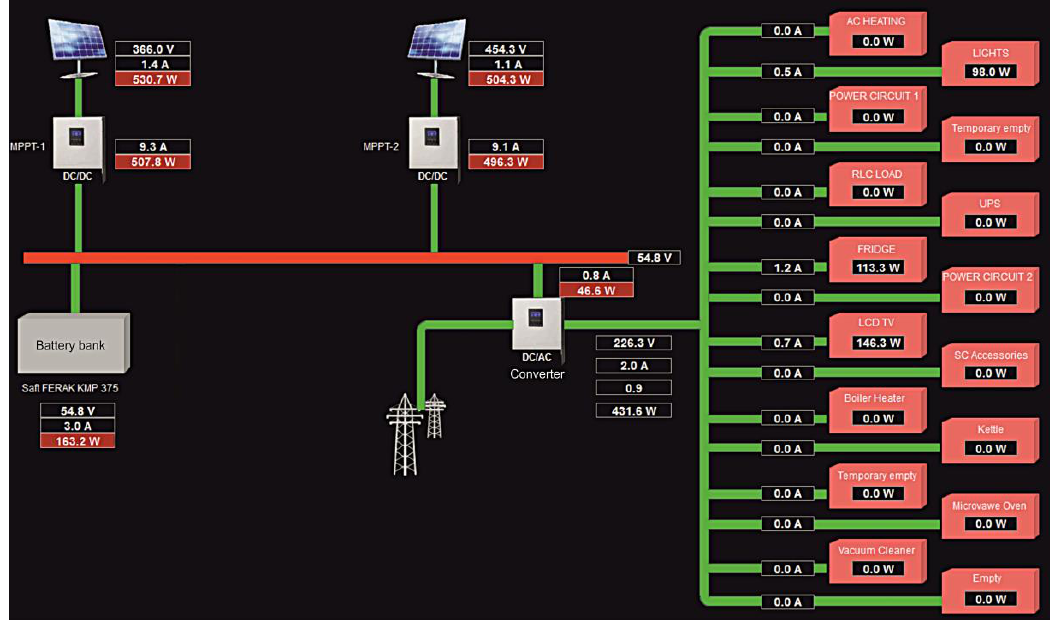
Figure 11. Smart Grid Laboratory (SGL) on-line visualization of the used appliances and the power sources.